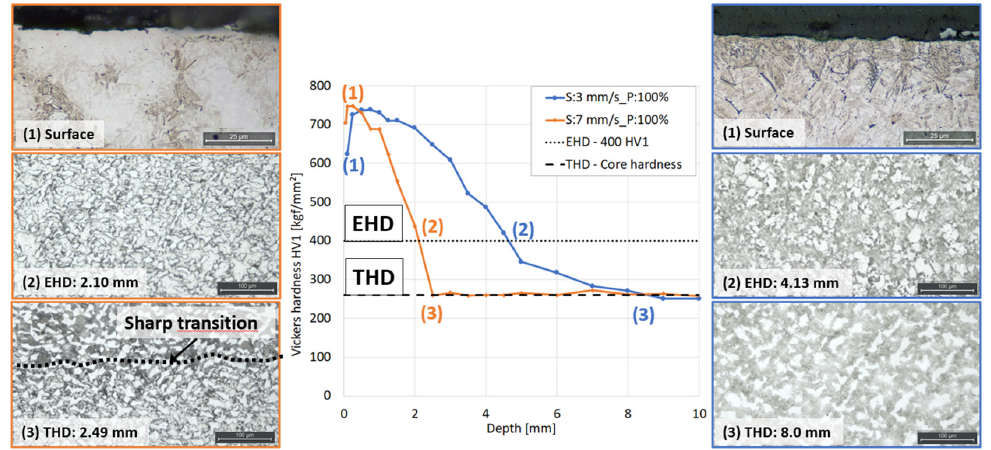
Figure 9. Micrographs at different depths (EHD: effective hardness depth, THD: total hardness depth) for left: sample with scanning speed (S) of: 7 mm/s and right: sample S: 3